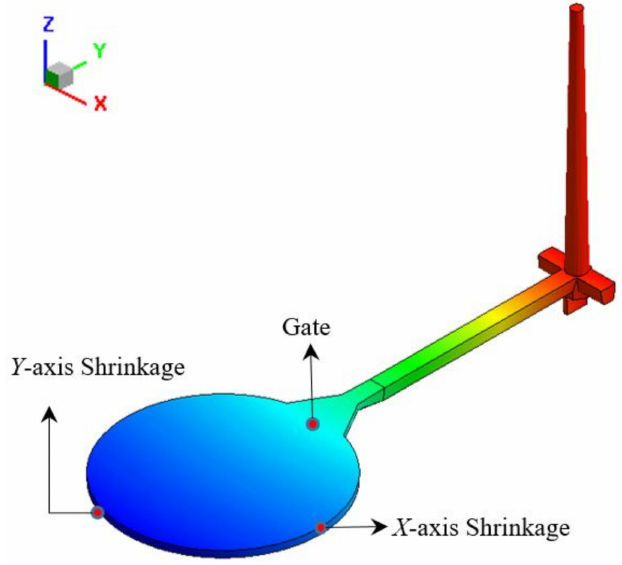
Figure 8. CAE data measurement location of the circular flat model.